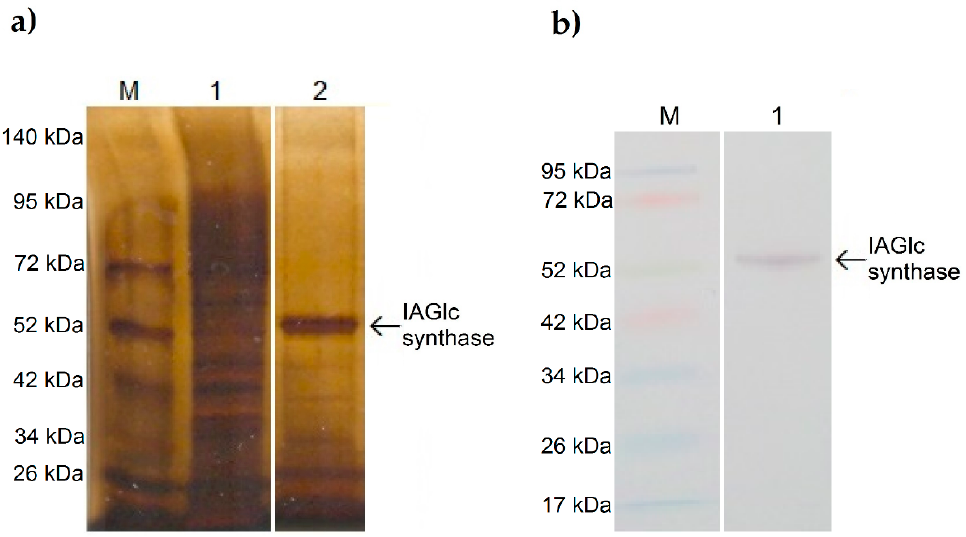
Figure 1. SDS-PAGE analysis of IAGlc synthase: M—molecular mass marker, 1—lysate, 2—purified IAGlc synthase fraction ( a ). Western blot analysis of IAGlc synthase: M—molecular mass marker, 1—purified IAGlc synthase fraction ( b ).